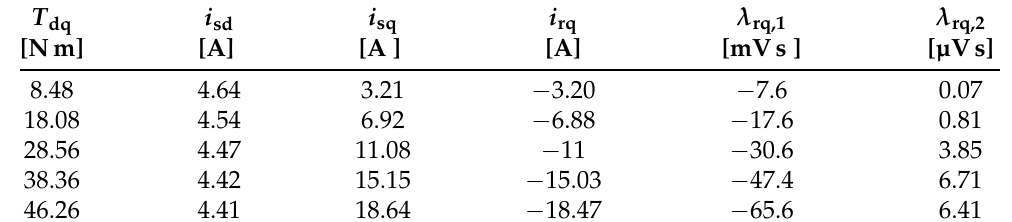
Table 2. RFOA results with rotor skewing.